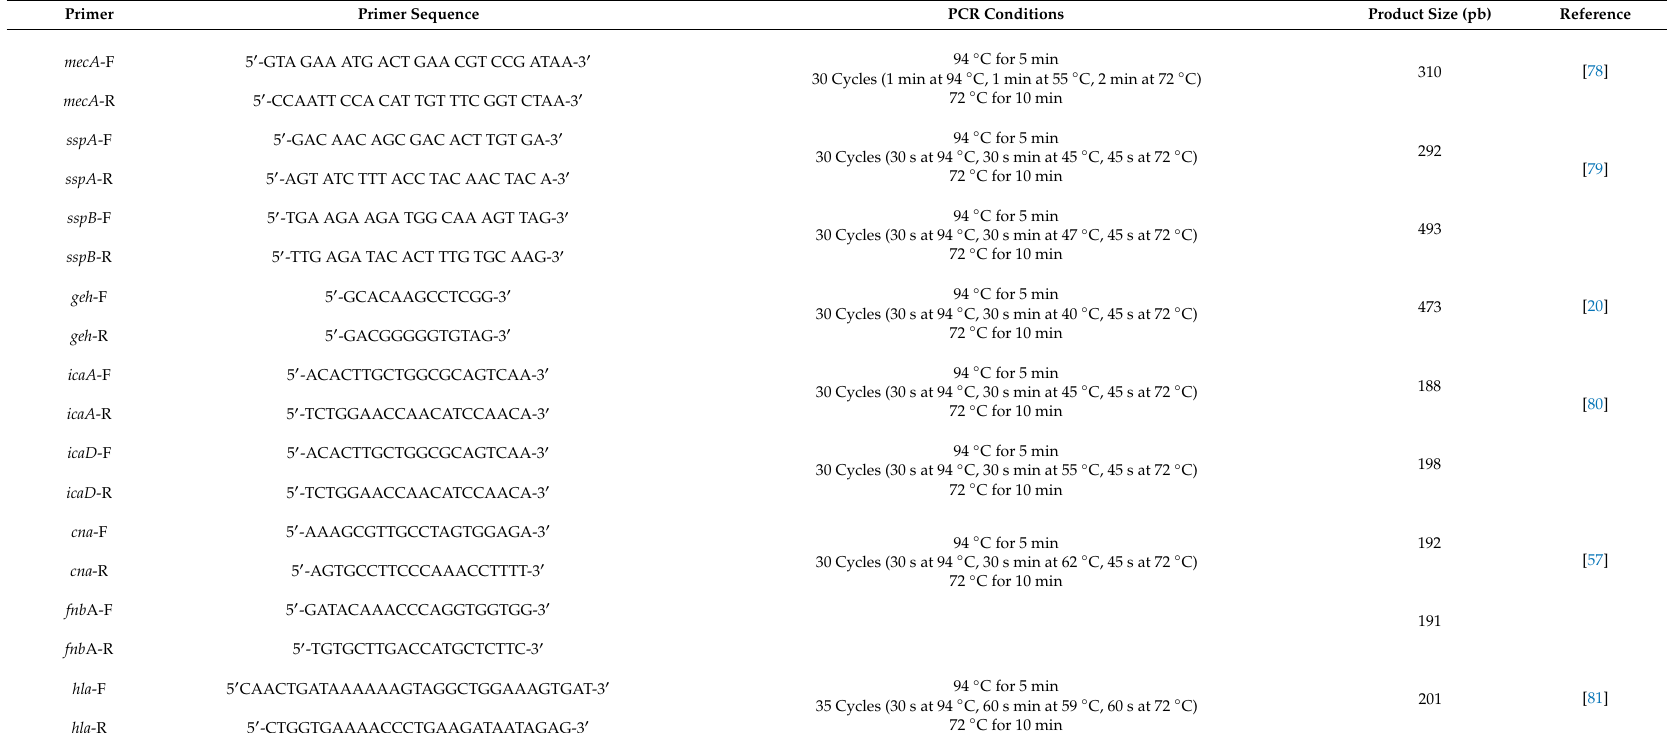
Table 7. Selected specific primers and PCR-amplification